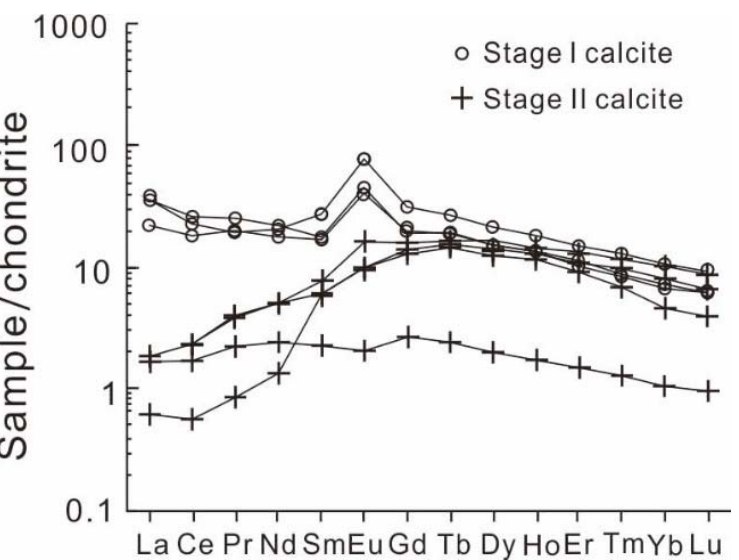
Figure 7. Plot of calcite REE patterns for the Beixiang stage I and II mineralization. Chondrite values are from reference [35]. Table 5. Calcite REE concentration of early and second ‐ stage mineralization from the Beixiang de ‐ posit.